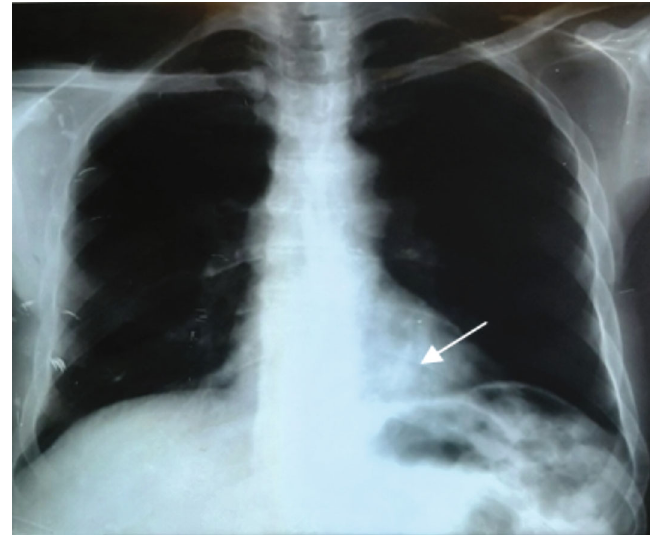
Figure 1: Chest X-ray face (solitary pulmonary nodule of the heart-phrenic